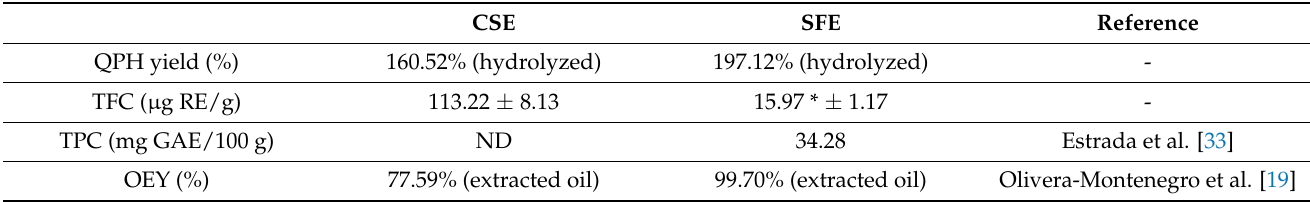
Table 4. Quinoa protein hydrolysate (QPH) yield, total flavonoid content, total phenolic content, and oil extraction yield obtained by conventional solvent extraction (CSE) and supercritical fluids’ extraction